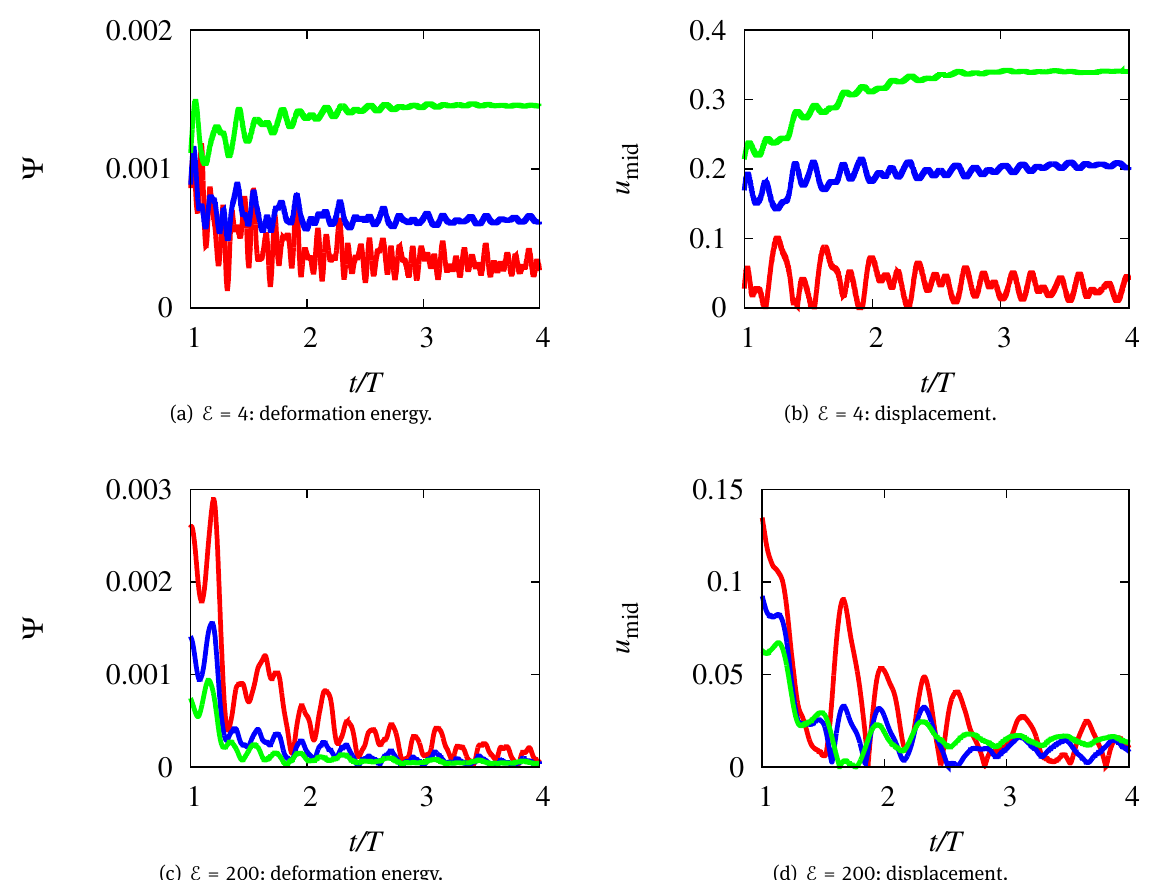
Figure 8: Time history of deformation energy and mid-point displacement at R = 15 (green curve), R = 50 (blue curve) and R = 100 (red curve). All the simulations are characterized by R = 100